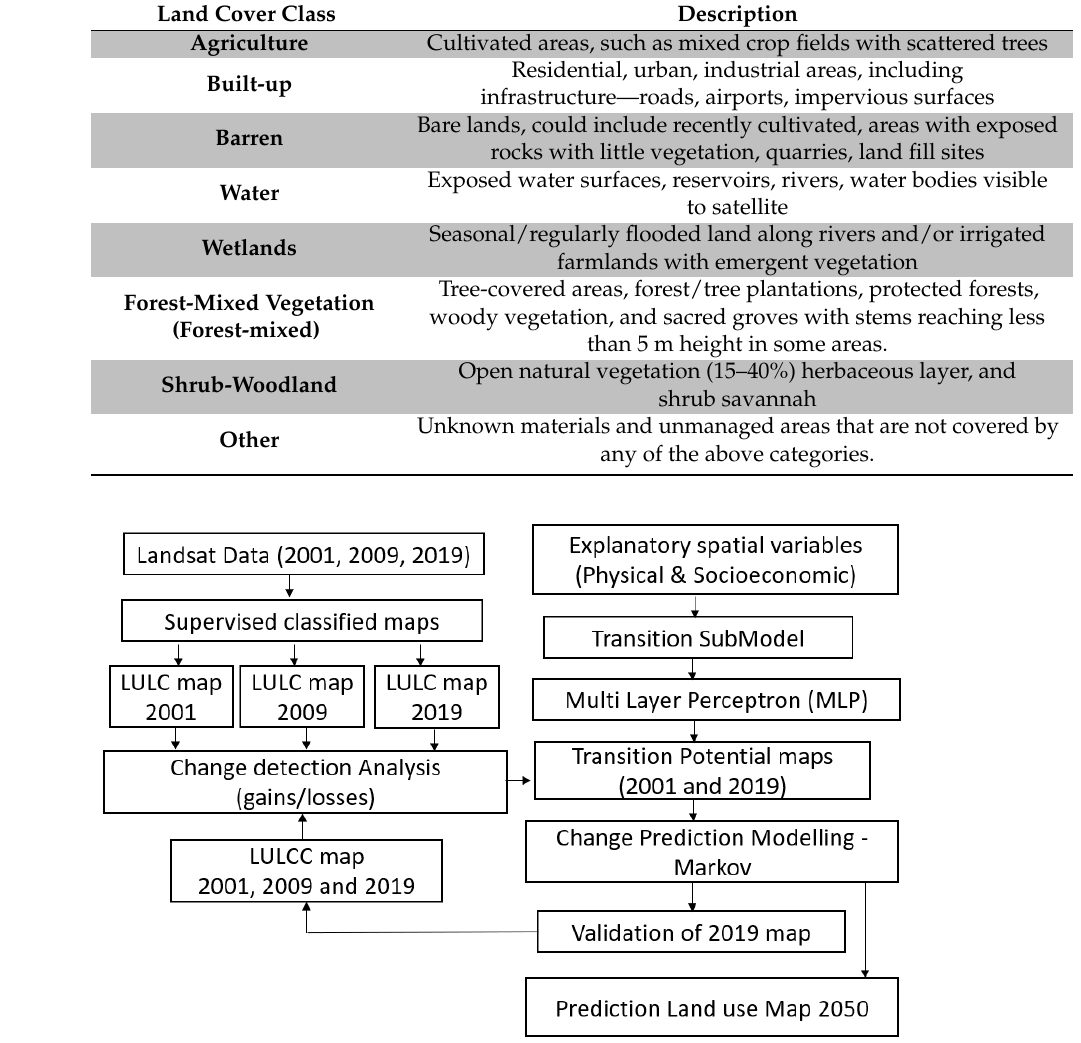
Table 3. Land class definitions (based on an 8-category classification system adapted from [10,52]).